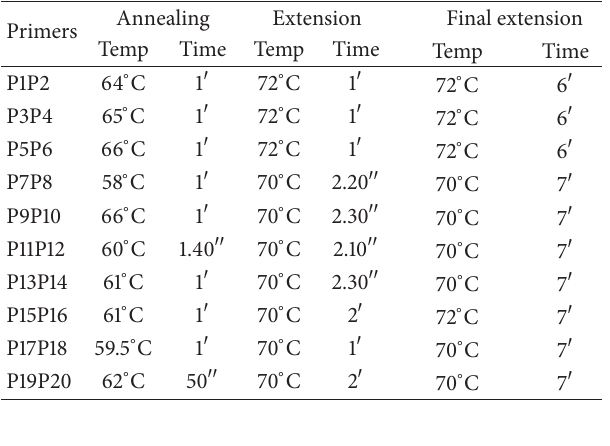
Table 2: PCR cycling information for amplifying specific alleles.